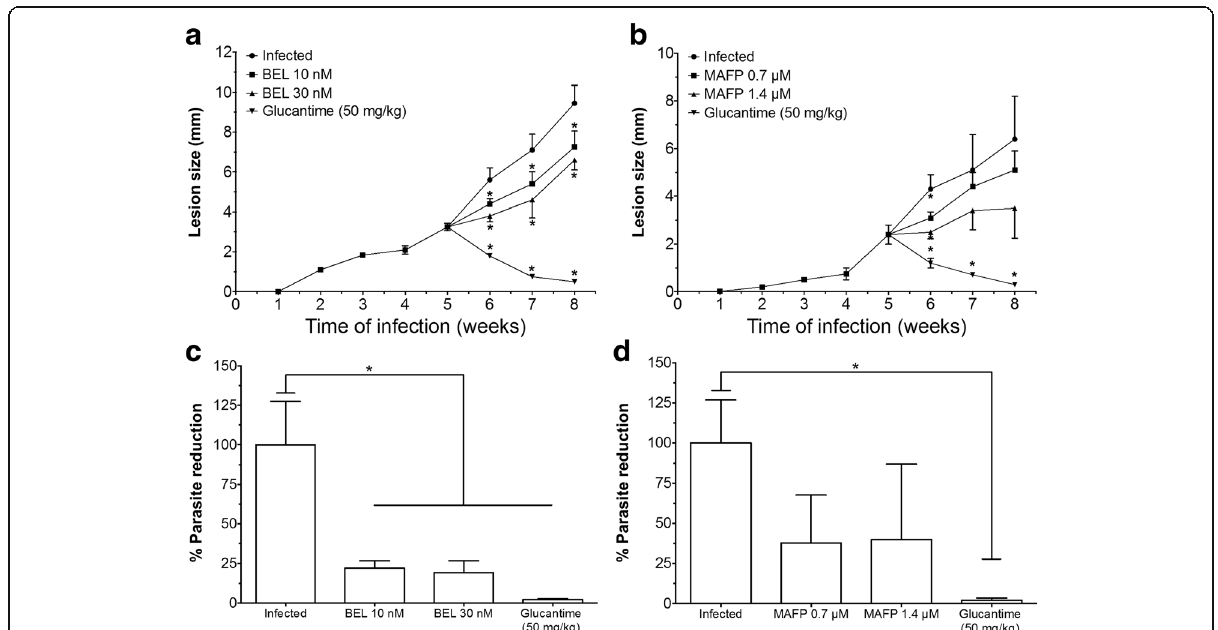
Fig. 1 BALB/c mice were infected in the right hind footpad with promastigote forms of L. amazonensis in stationary phase of growth. Five weeks after infection, the treatments were started and the lesion sizes of BEL- and MAFP-treated animals were recorded ( a and b , respectively), and the skin parasitism analyzed in the animals treated with BEL ( c ) and MAFP ( d ). *P<0.05 indicates significant differences when comparing the treated groups versus infected control group